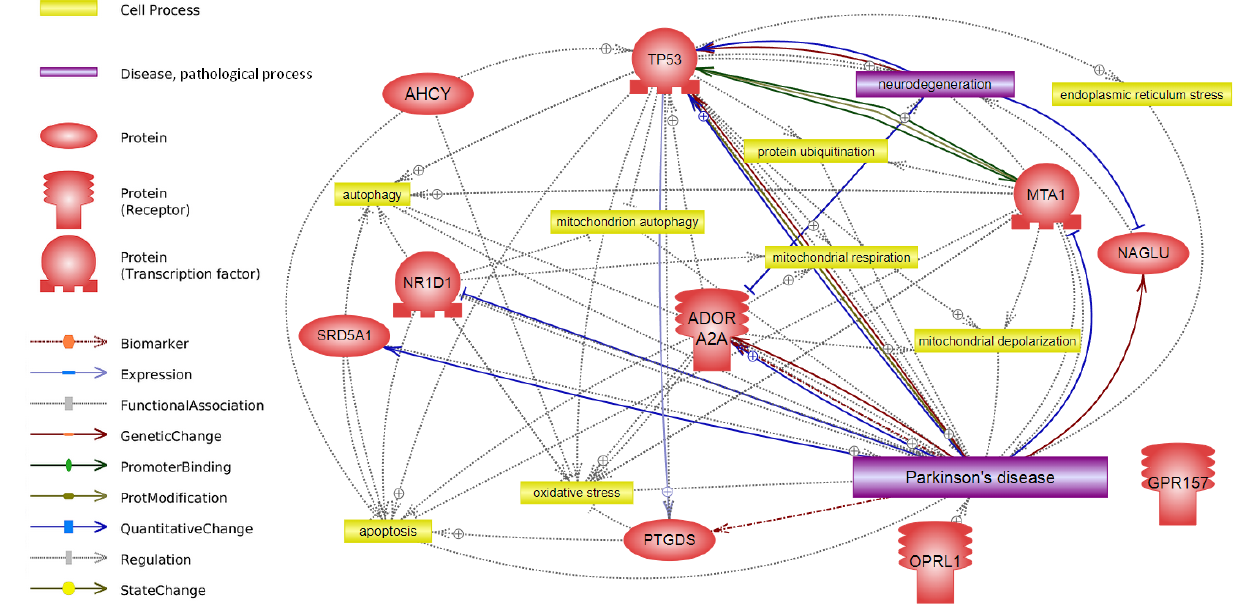
Figure 1. Interaction network of circadian behavior genes. The network was built using Pathway Studio v. 12.4.0.5.